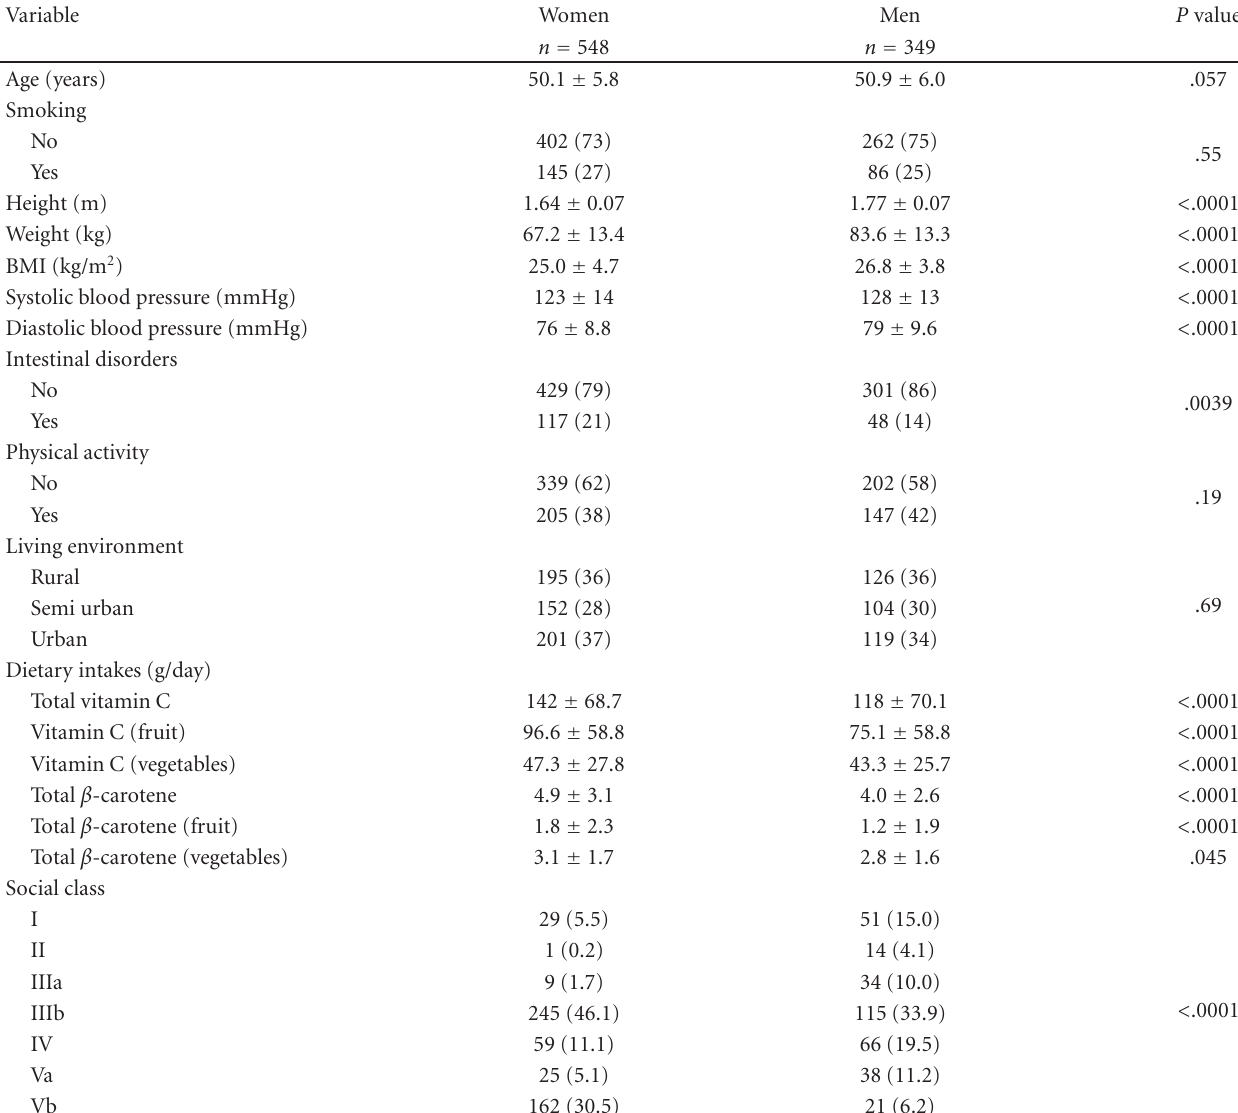
Table 1: Gender specific demographic, biometric, medical and dietary characteristics of the ELAN population. See text for description of social